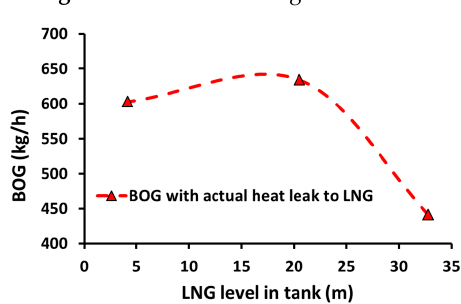
Figure 3. Total heat leakage to the tank.